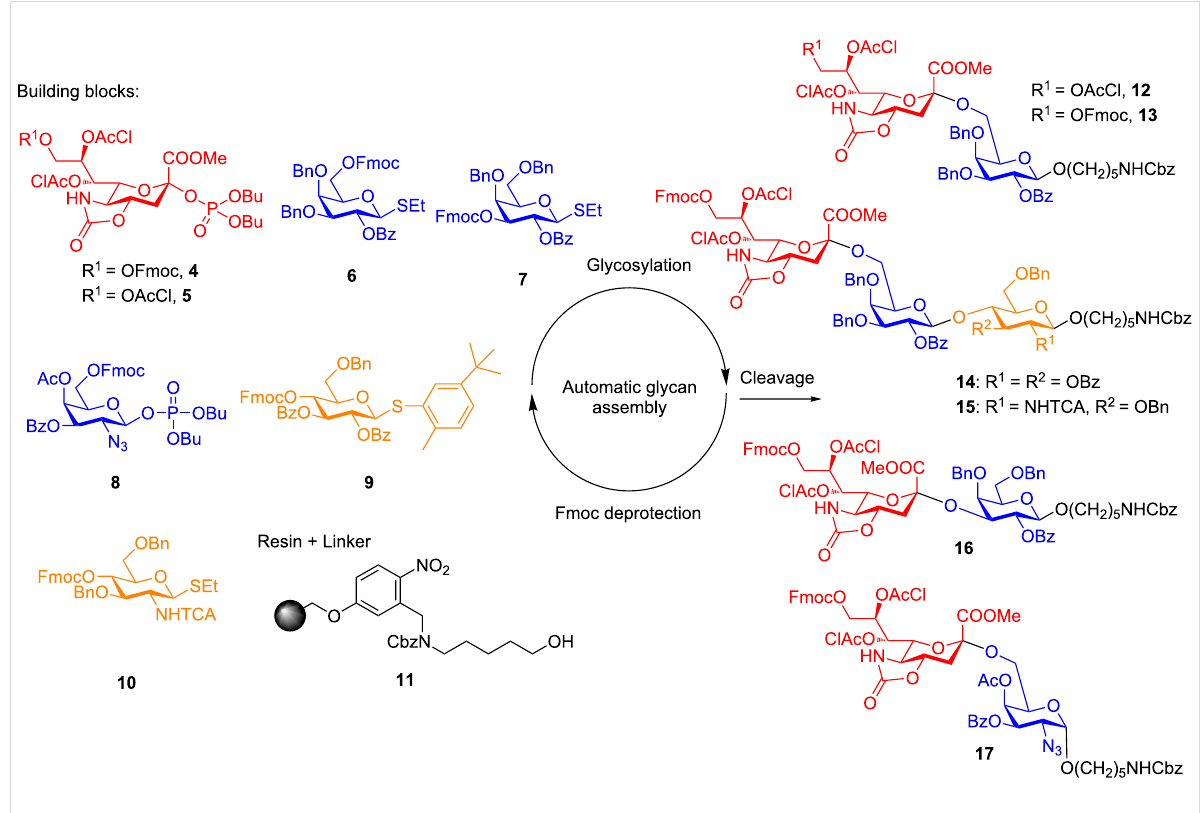
Scheme 2: Automated synthesis of oligosaccharides with α (2,3)-, α (2,6)-sialic acid linkages. Glycosylations: a) 2 × 5 equiv TMSOTf, ACN/DCM (1:1), − 50 °C (5 min), − 30 °C (10 min), − 20 °C (80 min), − 10 °C (10 min), 0 °C (10 min) for 4 and 5 . b) 2 × 5 equiv TfOH, NIS, DCM, − 40 °C (5 min), − 20 °C (30 min) for 6 and 7 . c) 2 × 5 equiv TMSOTf, DCM/dioxane (3:2), 20 °C (90 min), for 8 . d) 2 × 5 equiv TfOH, NIS, DCM, − 30 °C (5 min), − 10 °C (25 min) for 9 and 10 . Fmoc Deprotection: e) 3 × 20% NEt 3 in DMF, 5 min. Photocleavage: f) UV irradiation using a continuous flow reactor, DCM,